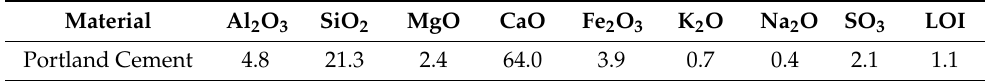
Table 1. Chemical compositions of the Portland cement type II (wt.%).